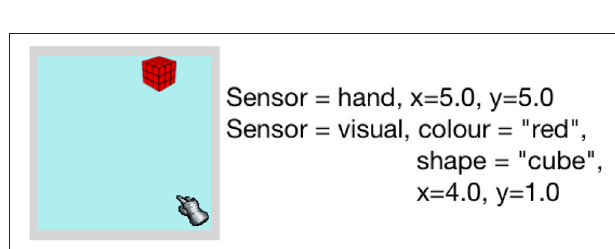
FIGURE 4 | Left: Simulator environment containing end-effector, and object. Right: Description of perceived sensory information of the environment.